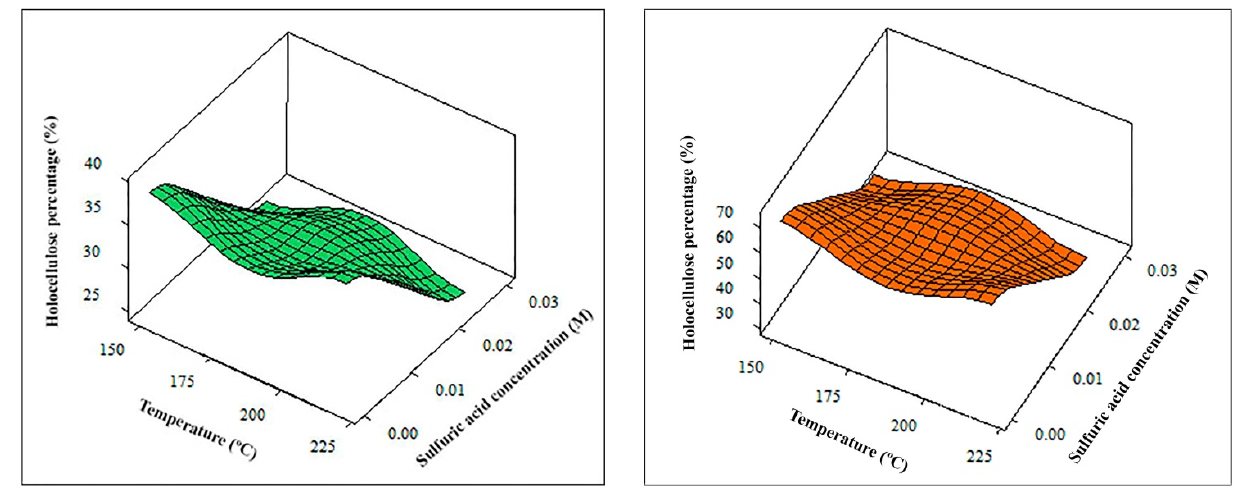
Figure 4. Response superficial for the solid recovery percentage in function of sulfuric acid concentration and tempera- ture for young ( ) and old ( ) lifs during thermochemical process.